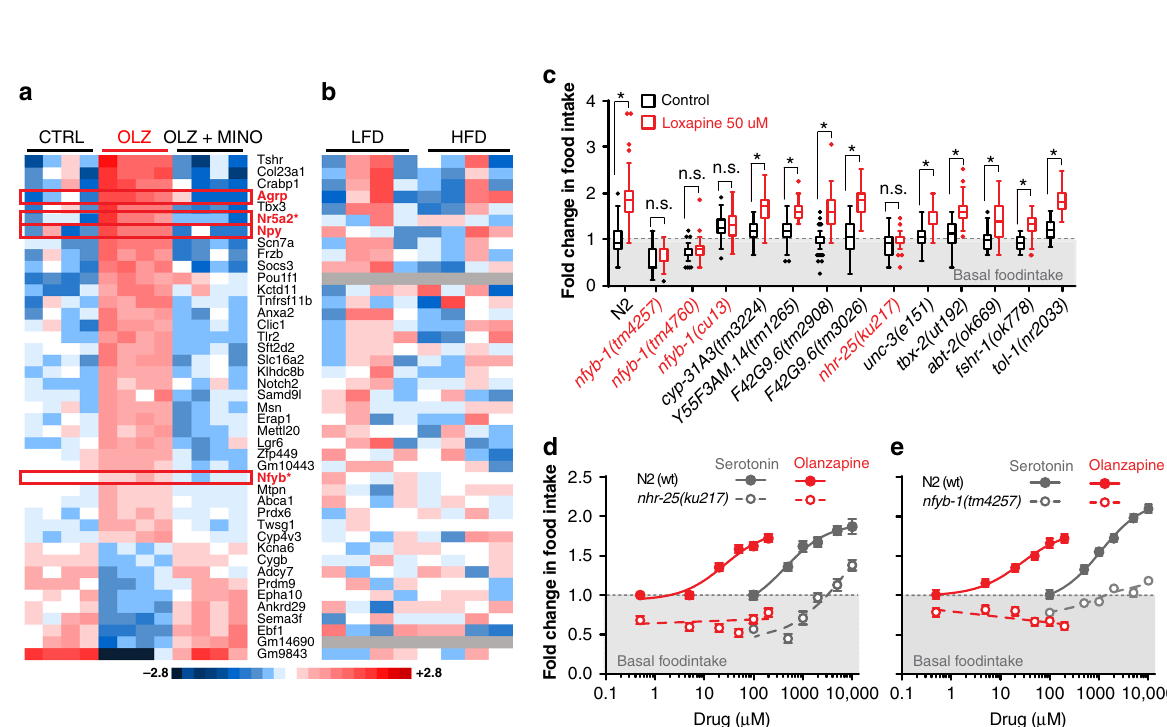
Fig. 4 RNA sequencing identi fi es gene expression pro fi le associated with AP-hyperphagia. a RNA-seq of hypothalamus of mice identi fi es unique signature of genes associated with AP-induced hyperphagia, n = 4 mice per group, control (CTRL), olanzapine (OLZ), and olanzapine + minocycline (OLZ + MINO). b Comparison of AP-induced pro fi le genes in model of low fat diet (LFD) and high fat diet (HFD) fed mice ( n = 4 per group). C. Testing AP-induced hyperphagia in various orthologous C. elegans mutants of genes identi fi ed from mouse hypothalamic RNA seq. d , e Comparison of food intake response of nhr-25 mutant ( d ) and ( e ) nfyb-1 mutant strains, to olanzapine induced hyperphagia and serotonin-induced hyperphagia compared with N2 (wild type control worms). Error bars in dose response plots ( d , e ) represent mean and + / − S.E.M of 14 – 21 replicate wells with 5 – 15 animals each. Data in c are represented by a tukey style plots with the box representing the upper and lower quartile. ANOVA, Holm-Sidak corrected. For number of animals